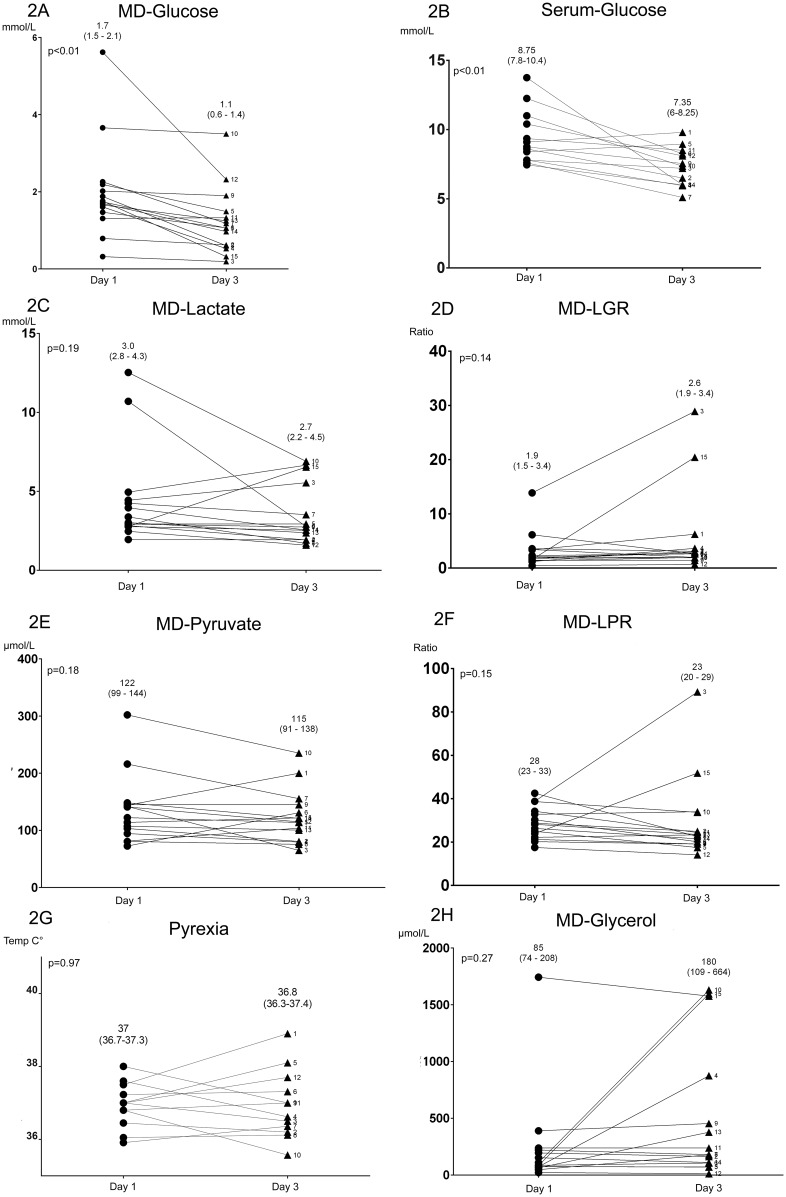
MD parameters, fever and serum glucose over time.Illustrating parameter change over time (median 0–24h, Day 1, vs median 48–72h, Day 3) from insertion of microdialysis (MD) catheters. MD-glucose (2A) and serum-glucose (2B) levels were significantly lower on Day 3 compared to Day 1 (p<0.01 respectively, Wilcoxon matched-pairs signed rank test). No other parameter presented any significant difference over time. For all parameters n = 15 patients are compared except pyrexia (n = 13).